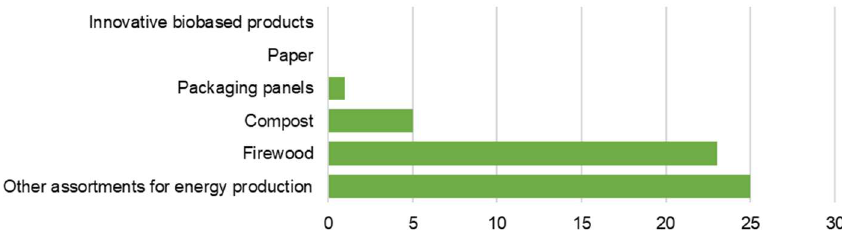
Figure 4. Destinations of wood waste and by-products in the Salerno province (N. of respondents).